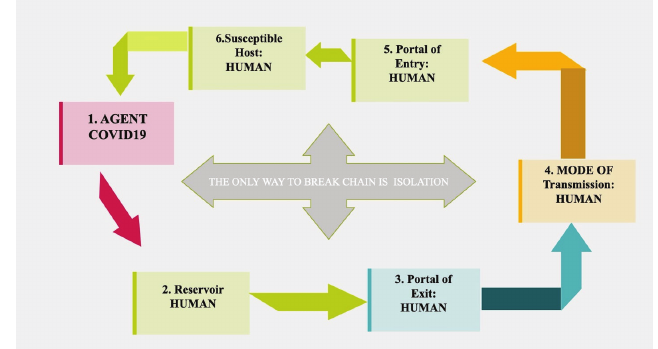
Figure 1 - Chain infection of